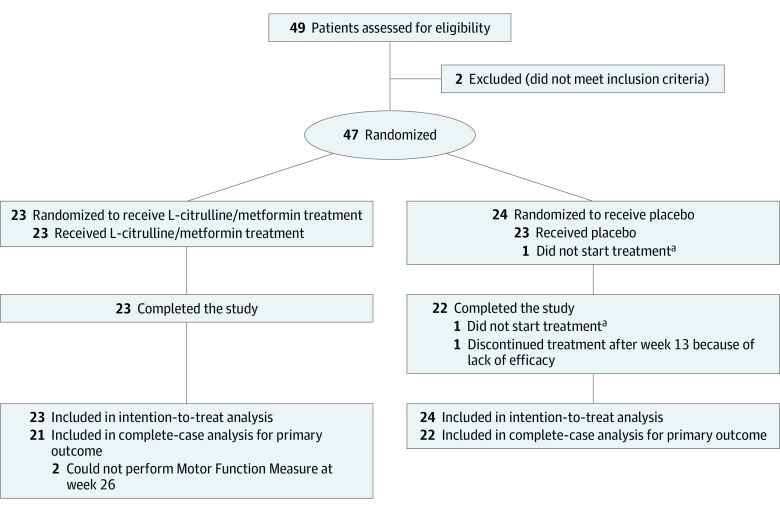
CONSORT Flow DiagramaIndicates the same patient.